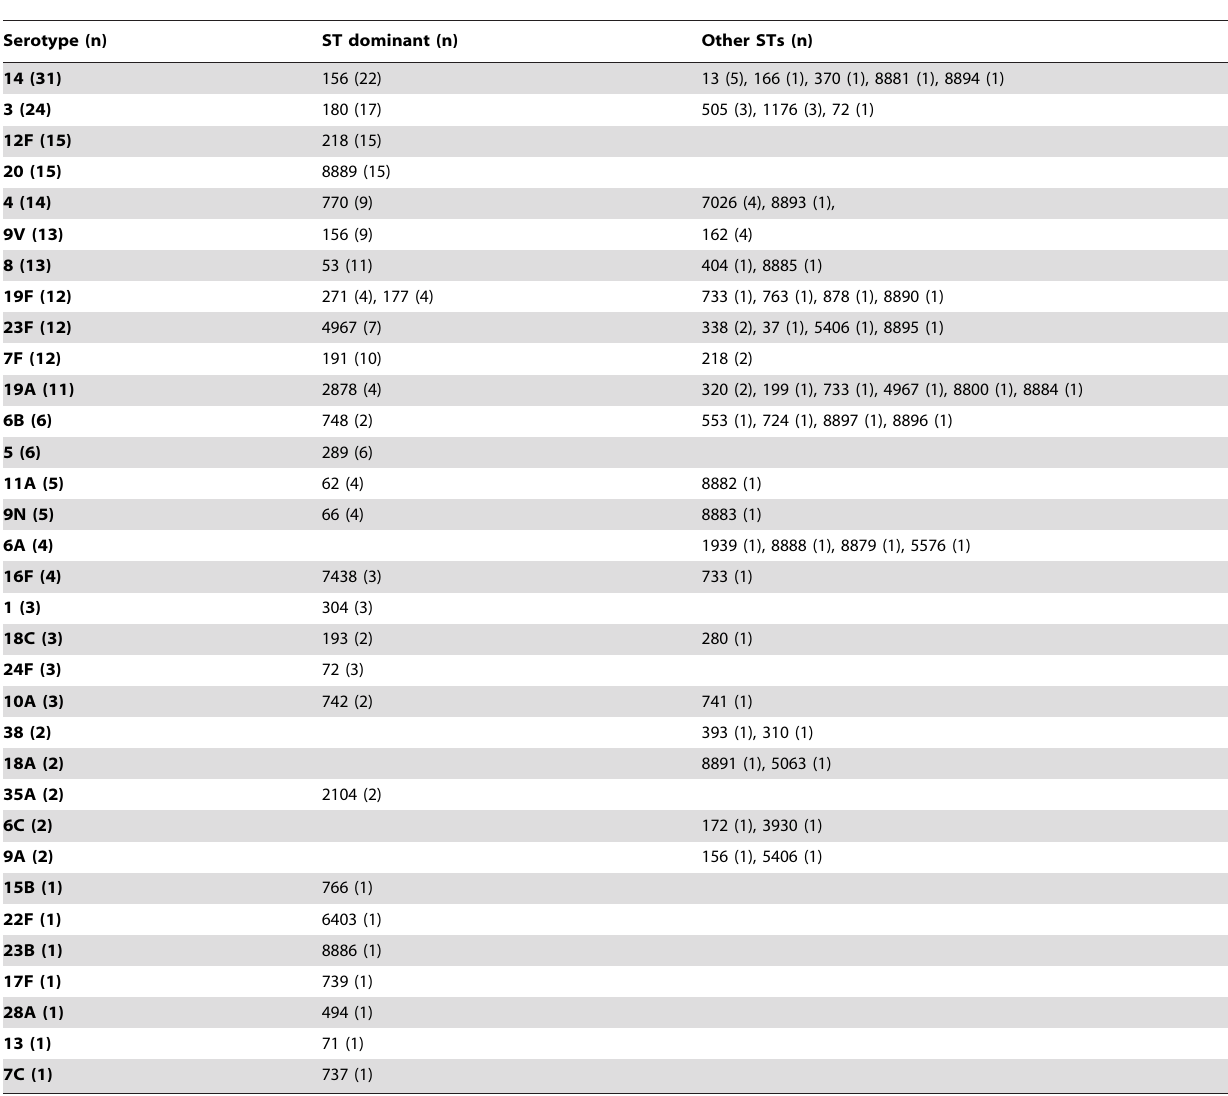
Table 3. Serotypes and STs observed among 231 pneumococci recovered from IPD (2007–2012).